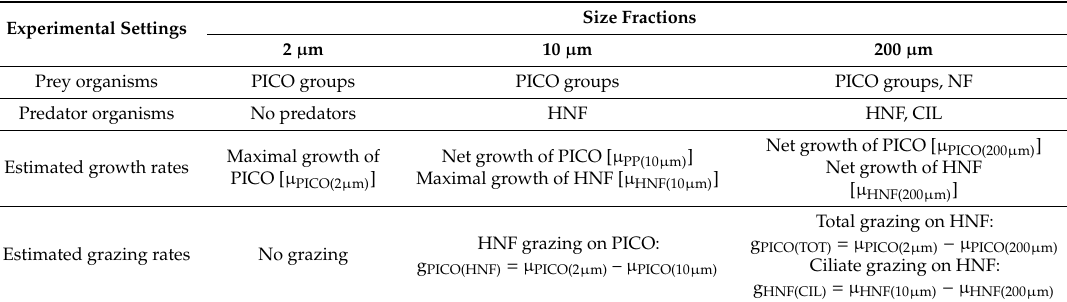
Table 1. Determination of growth and grazing parameters in the size-fraction grazing experiments. Picoplankton (PICO) include three components: heterotrophic bacteria, Prochlorococcus, and fraction, respectively. HNF, heterotrophic nanoflagellates; CIL, ciliates; gPICO(TOT), total grazing rate on PICO groups; gPICO(HNF), HNF grazing rate on PICO groups; gPICO(CIL), ciliate grazing rate on PICO groups; gHNF(CIL), ciliate grazing rate on